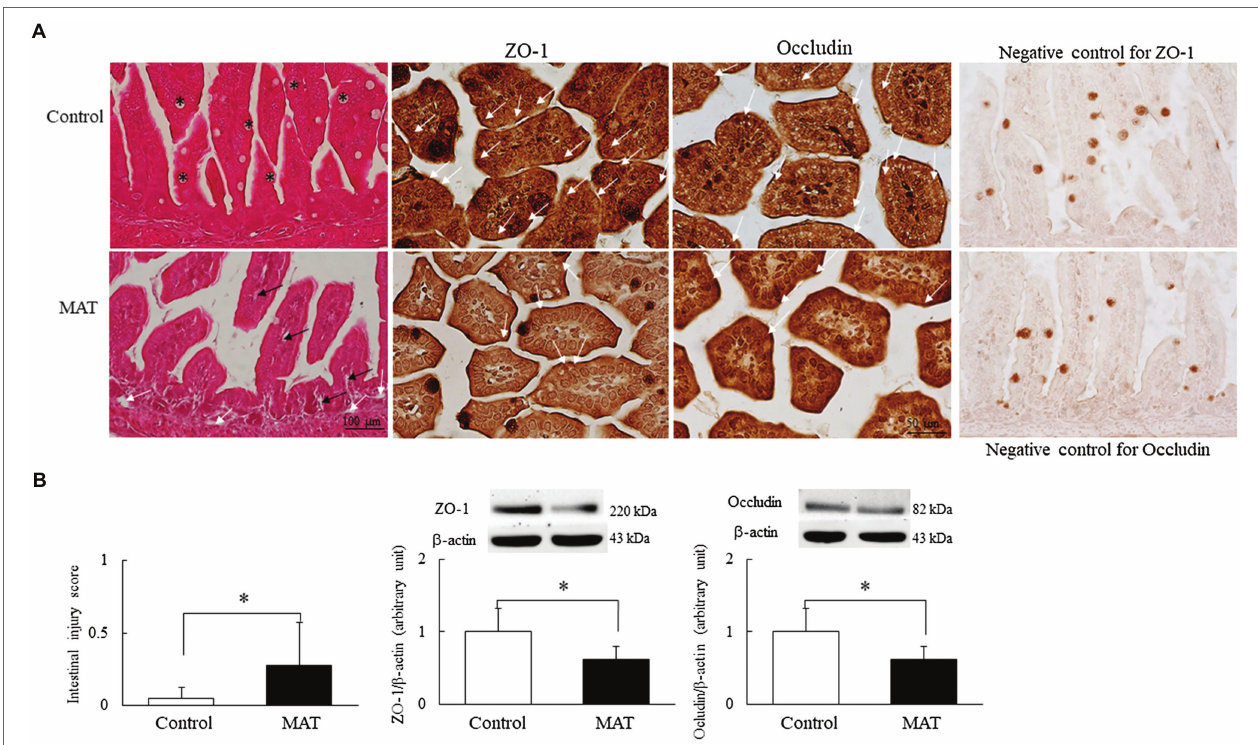
FIGURE 3 | Effects of MAT on (A) immunohistochemistry of the ileum and (B) intestinal injury score and Western blotting of tight junction proteins in 7-day- old mice. Compared with the mice born to the control dams, the mice born to the antibiotic-treated dams exhibited fewer goblet cells (asterisk) in the epithelium and a significantly higher intestinal injury score; they also exhibited dilated capillaries and lacteal ducts in the lamina propria of the villi (black arrow) and separated lamina propria in the basal portion of the mucosa from the submucosa (white arrow). Mice born to the control dams exhibited intact construct of ZO-1 and occludin staining (white arrow). Those born to the antibiotic-treated dams exhibited disrupted ZO-1 and occludin immunohistochemistry between adjacent enterocytes and significantly lower ZO-1 and occludin protein expression levels than the mice born to the control dams ( n = 9). * p < 0.05. MAT, maternal antibiotic